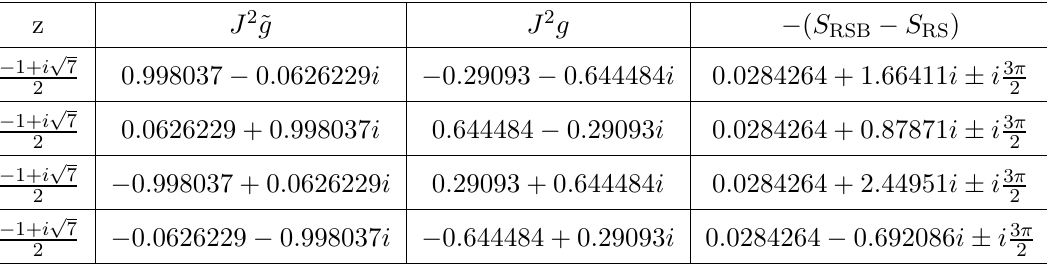
Table 1 . Di(cid:11)erence between the saddle point actions for the replica o(cid:11)-diagonal and replica diagonal saddle points, (cid:0) ( S (cid:0) S ). The real part of the replica-o(cid:11)-diagonal saddle point action is lower RSB RS than the that of the replica-diagonal saddle point, which indicates the dominating contribution of the replica-o(cid:11)-diagonal saddle